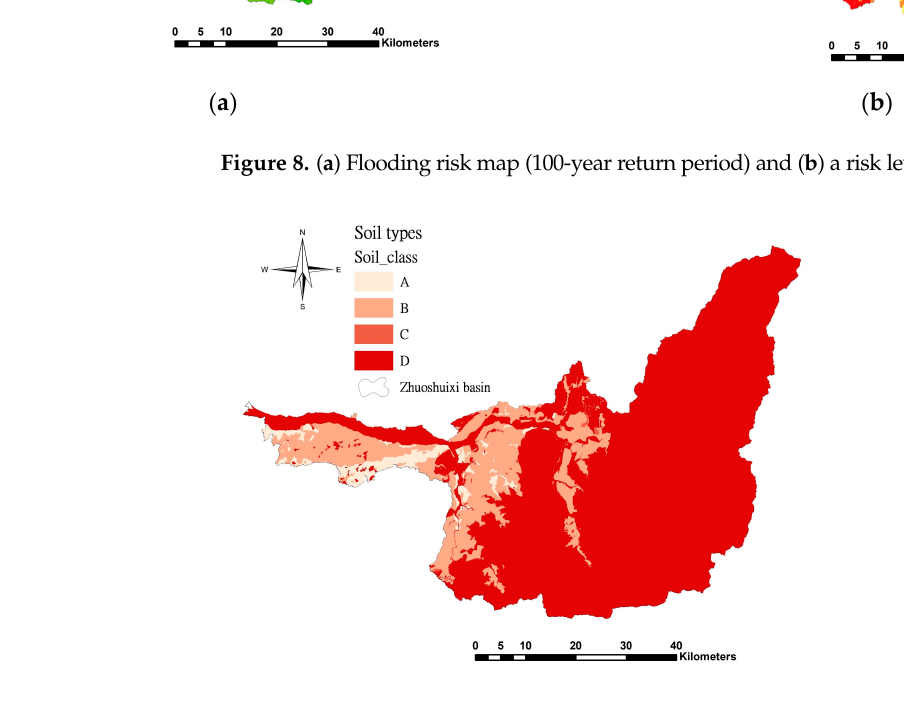
Figure 9. SCS soil texture classification.